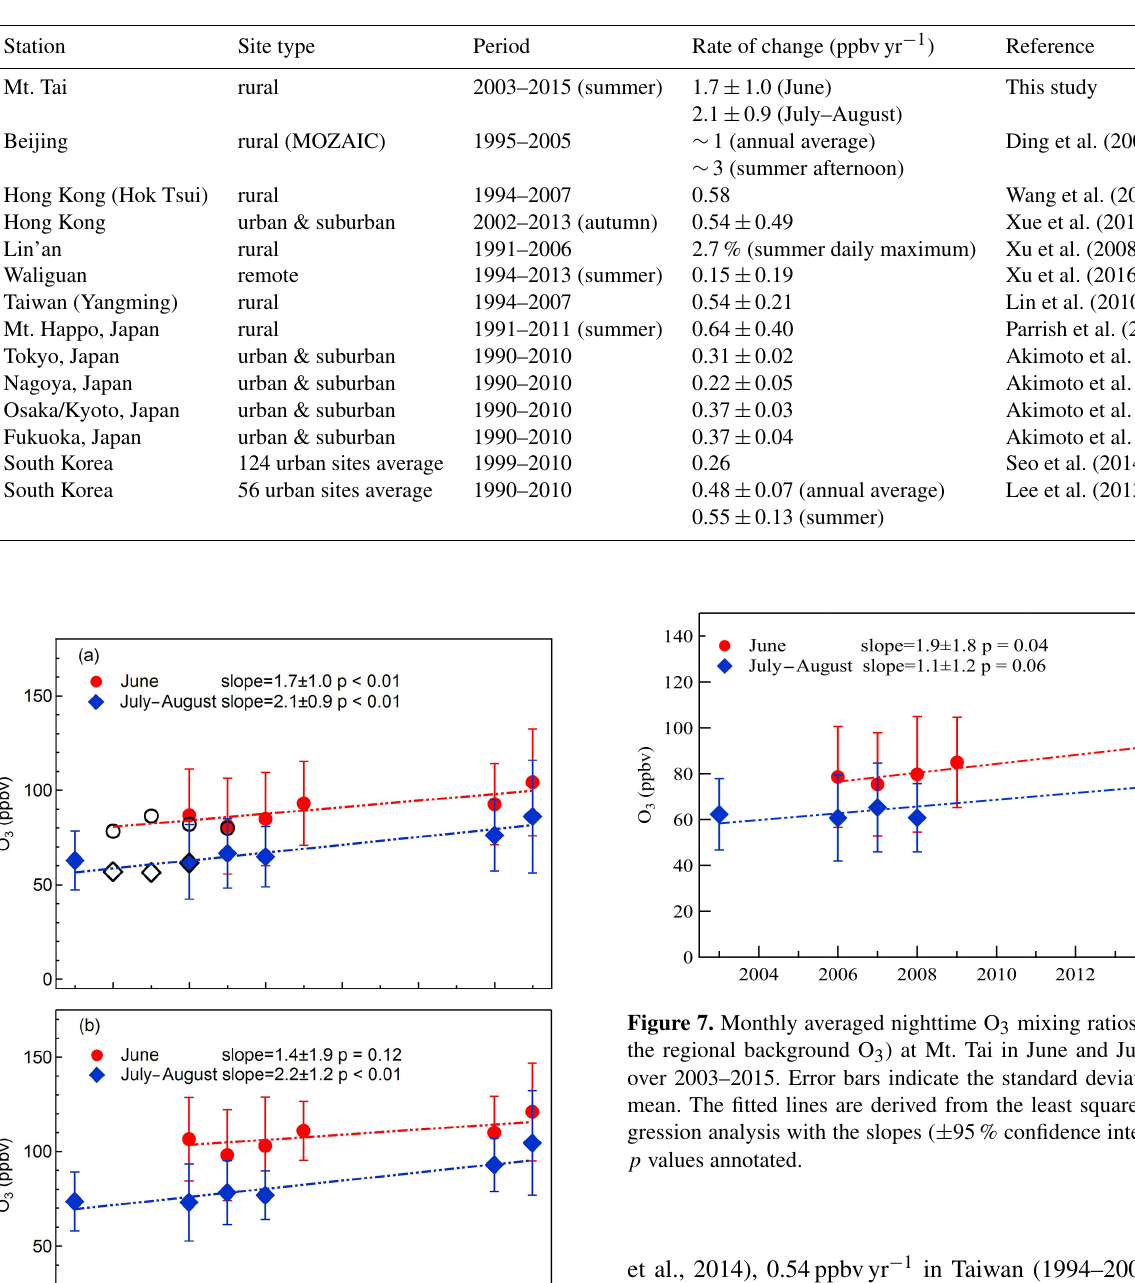
Table 4. Summary of surface and lower tropospheric ozone trends recorded in East Asia.